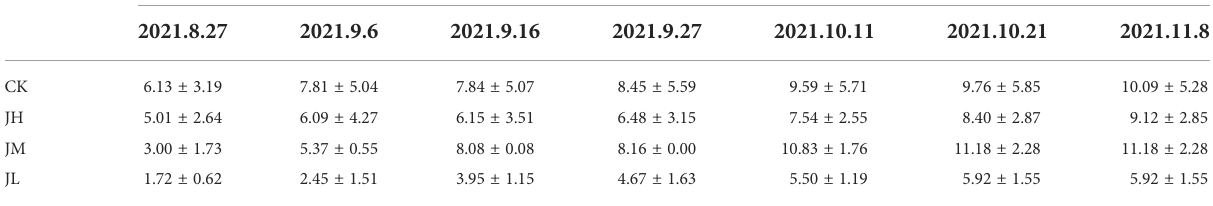
TABLE 2 Bolting rate of Qianhu in different periods.